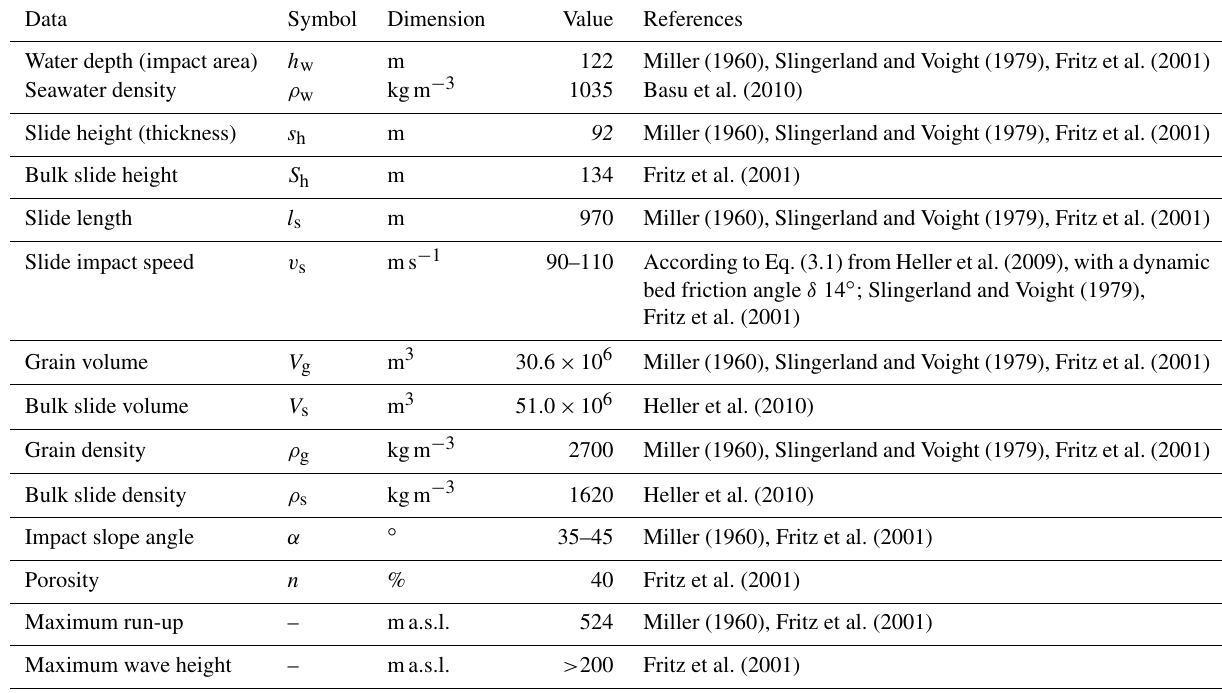
Table 1. Summary of the governing parameters of the 1958 Lituya Bay tsunami event and related references.